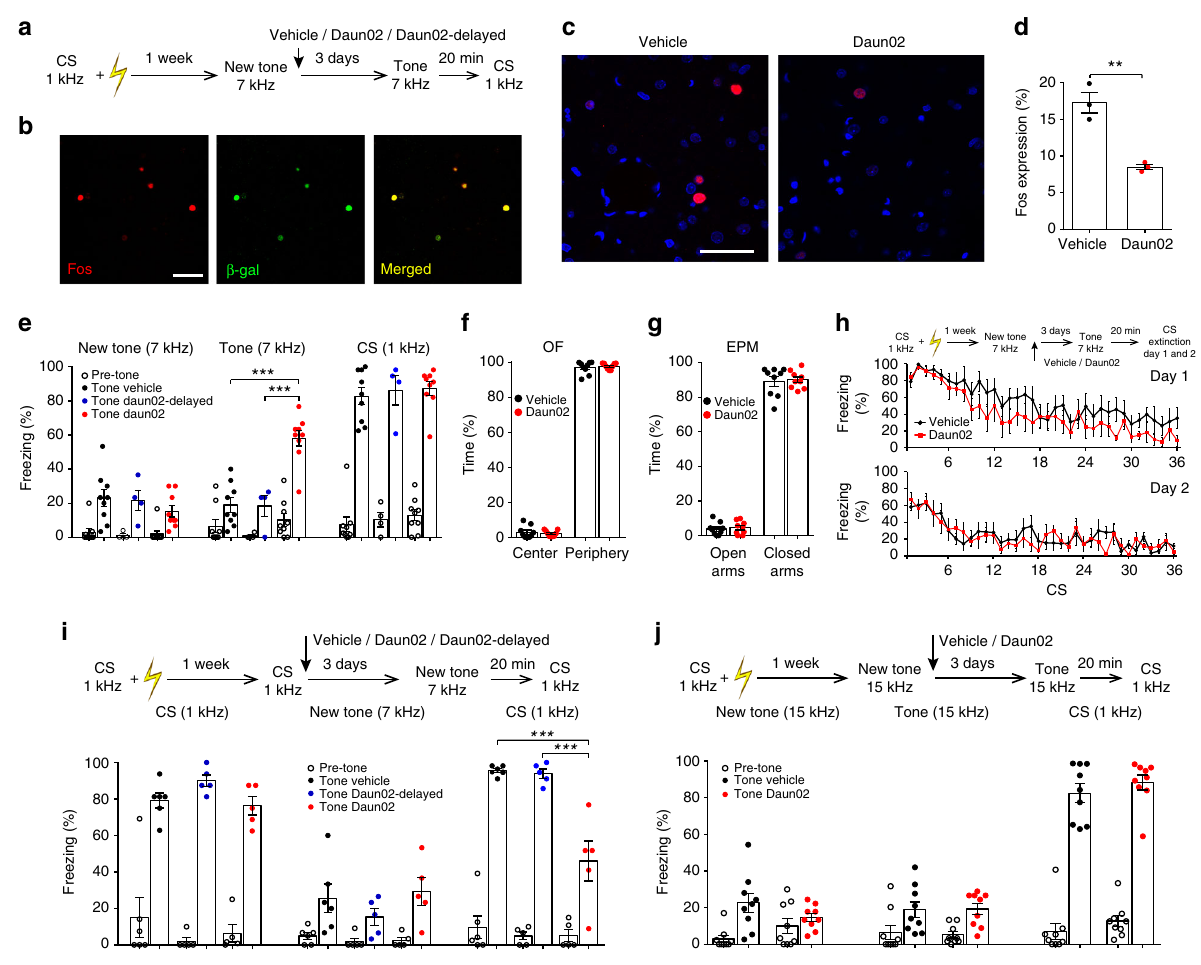
Fig. 4 LA neurons activated by a new tone presentation are necessary for fear discrimination processes. a Experimental design for the Daun02 inactivation technique, see Methods for details. Daun02 ( n = 9),Vehicle ( n = 9), “ Daun02-delayed ” group ( n = 4). b New tone presentation induced Fos (red nuclei) and β -galactosidase (green nuclei) expression in LA neurons. The merged panel shows nuclei that were double-labeled for β -galactosidase and Fos (yellow). Scale bar, 100 µ m. c Photomicrographs of Fos-stained LA neurons in the Vehicle- (left) and Daun02-injected (right) rats at 90 min after 7